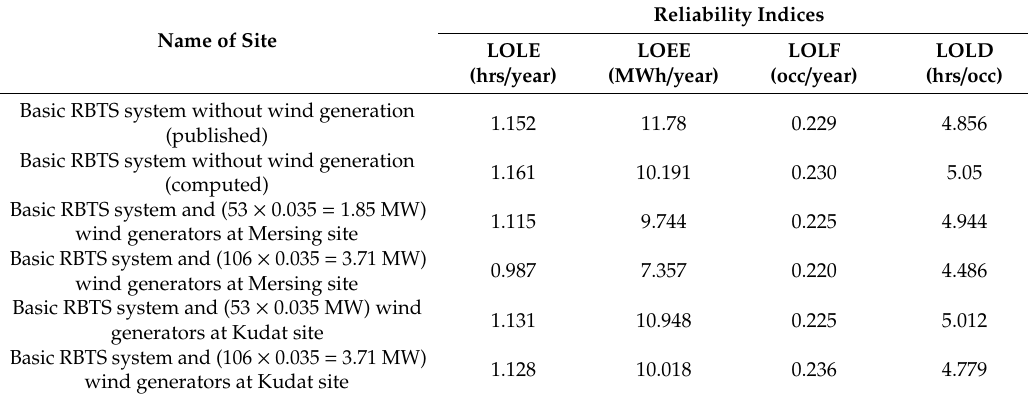
Table 5. Reliability indices at various sites in